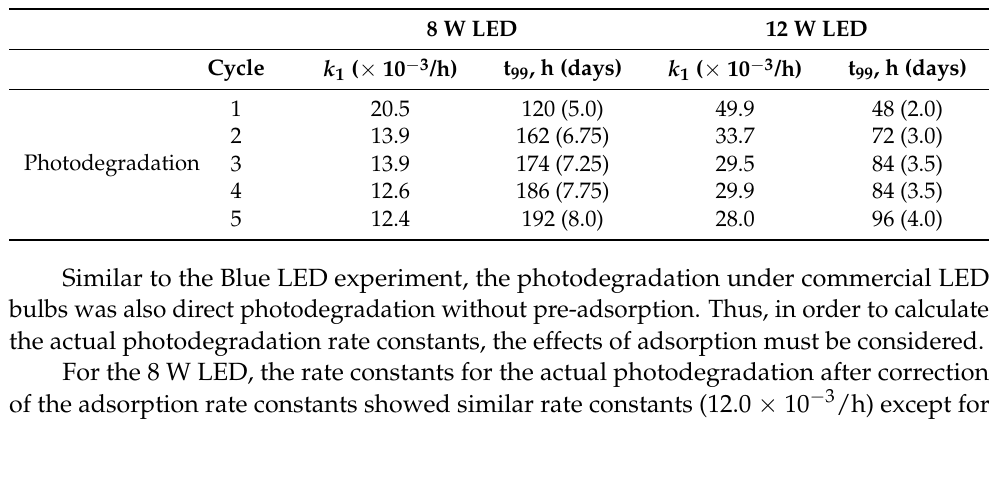
Figure 13. Photodegradation kinetics of MB under a commercial 12 W LED bulb: ( a ) MB removal and ( b ) normalized plot for pseudo-first-order. Table 4. Photodegradation kinetics of MB removal under commercial LED